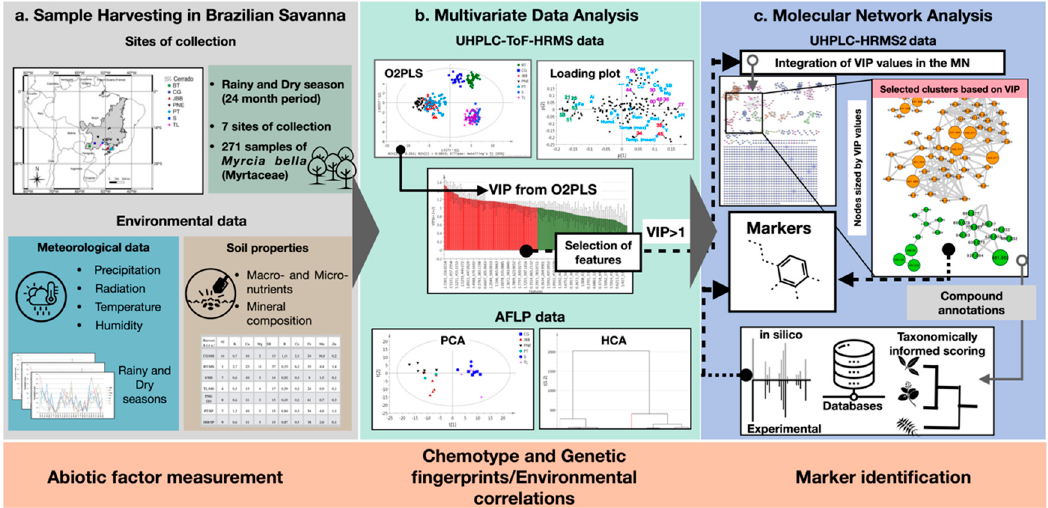
Figure 1. Summary of the workflow used in this study. ( a ) Strategy followed for sample harvesting and environmental monitoring in different regions of the Brazilian savanna. ( b ) Multivariate data analysis was used to analyze the chemical and genetic data and to correlate compounds with significant variation (markers) to environmental factors. ( c ) A multi-informative molecular network was then generated by merging metabolomics multivariate data (VIP values) in the molecular network to identify chemotype markers. Compounds were annotated by spectral matching against in silico fragmentation databases, following a taxonomically informed reranking process.